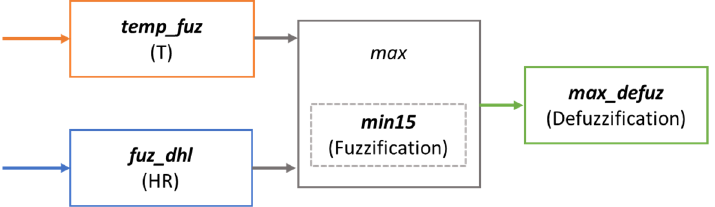
Figure 3. Representation of the fuzzy logic controller (FLC) modules to be implemented in Verilog ® language, showing the process sequence, where temperature (T) and relative humidity (RH) are inputs to the fuzzification and defuzzification modules.